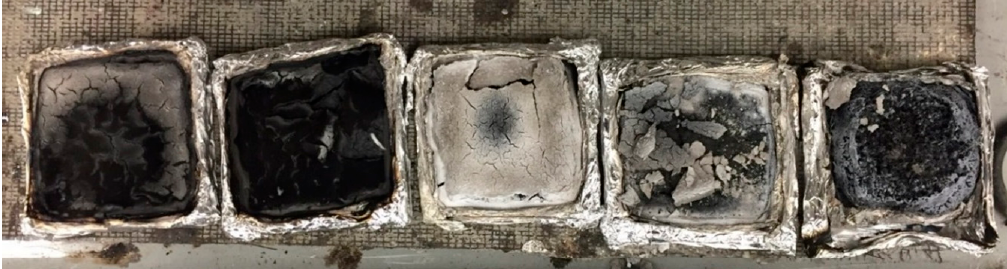
Figure 6. Photos of the different samples after the tests. From left to right: sample 1 (100:130), sample 5 (100:100), sample 9 (100:66), sample 13 (100:33), and sample 17 (100:0).